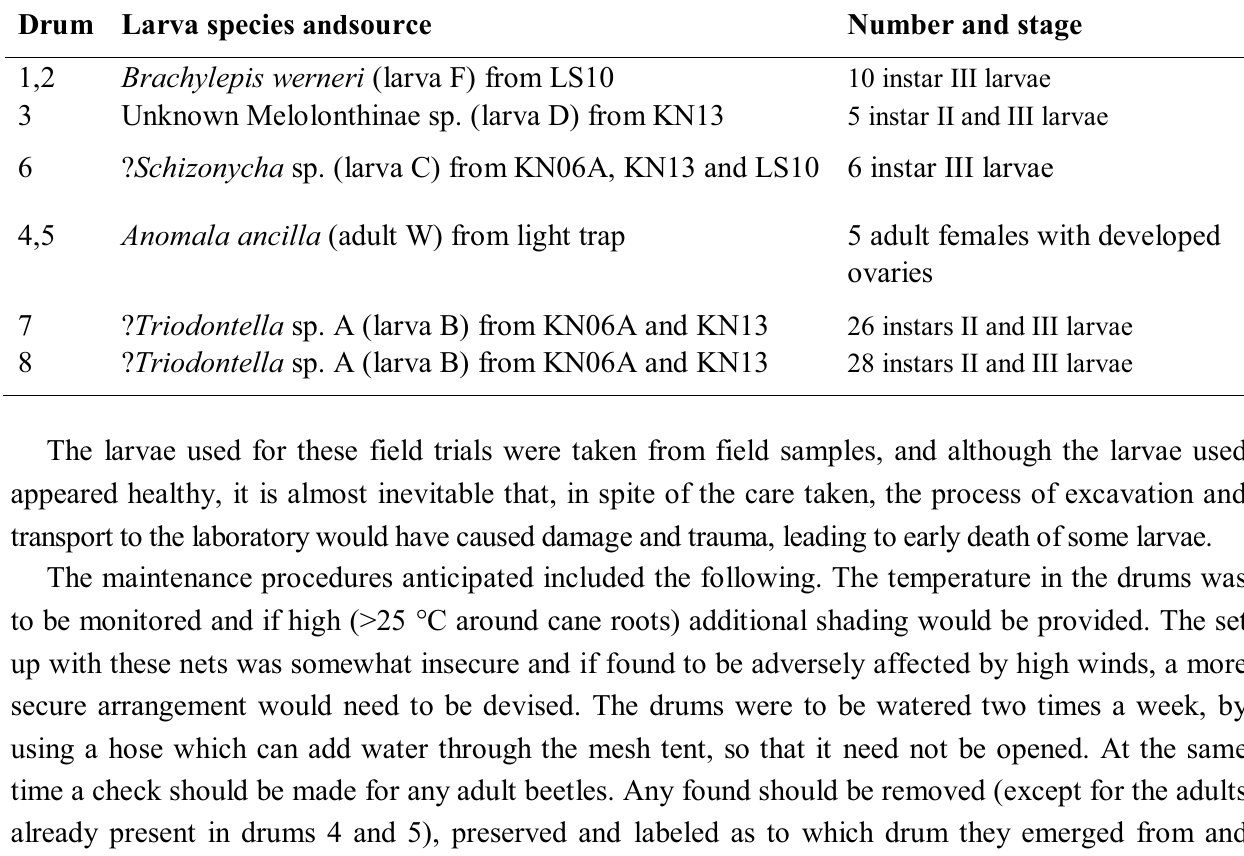
Table 1. Rearing trials studies set up in half-drums, 1 November